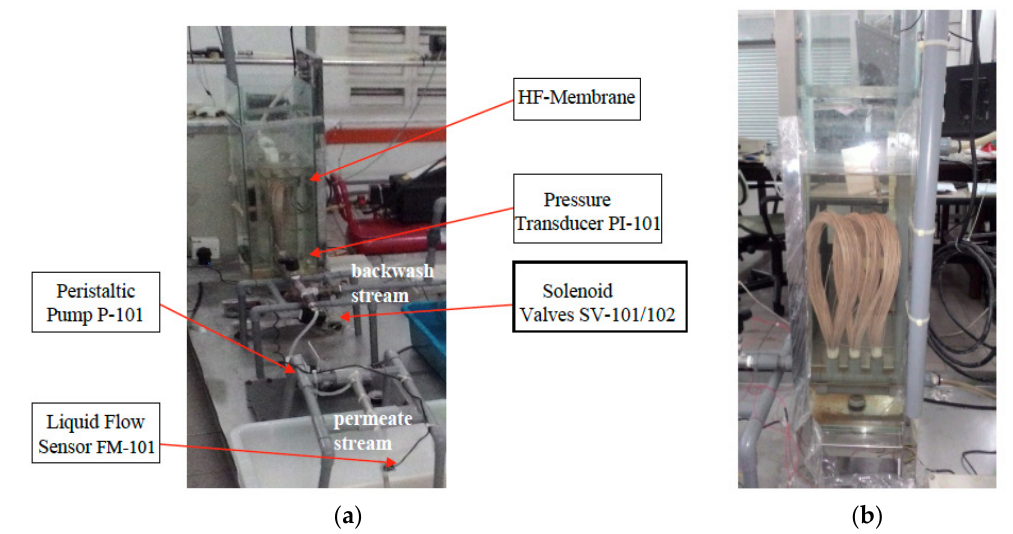
Figure 3. ( a ) Submerged MBR bench scale plant; ( b ) Hollow Fibre (HF)-Membrane (with three membrane modules).